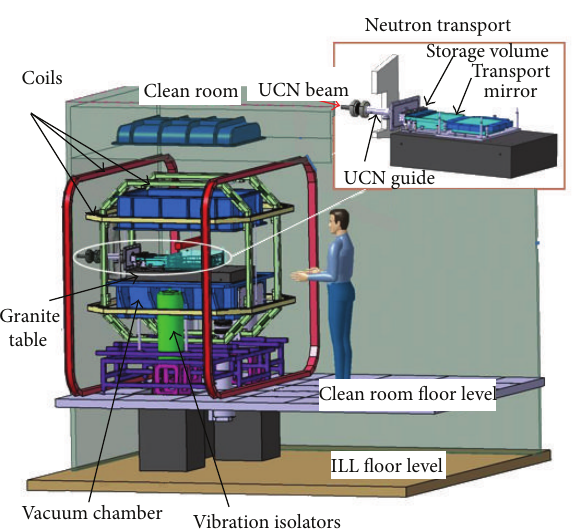
Figure 2: The spectrometer in the cleanroom. Measurement and control instruments are installed on a flat massive granite table with the mass of 550 kg, all inside a welded aluminum vacuum chamber with passivated wall surfaces. All this is placed in a clean controlled area (ISO 5) in order to protect the delicate optical elements.